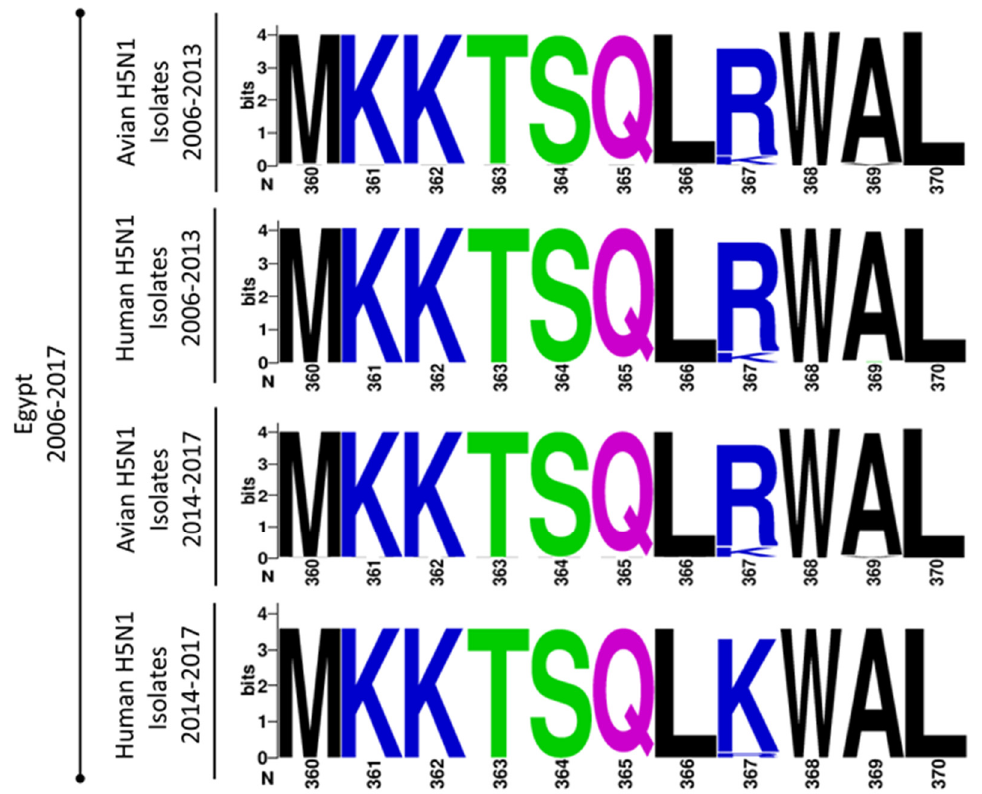
Figure 6. Prevalence of lysine and argenine at amino acid (aa) residue 367 among Egyptian human and avian H5N1 isolates (2006 to 2017). The graphic was created via Web-based WebLogo application (http://weblogo.threeplusone.com/create.cgi) [29]. The aa color is given according to their chemical properties. Polar aa “T and S”: green; neutral aa “Q”: purple; basic aa “K and R”: blue; hydrophobic aa “M, L, W, A and L”: black.